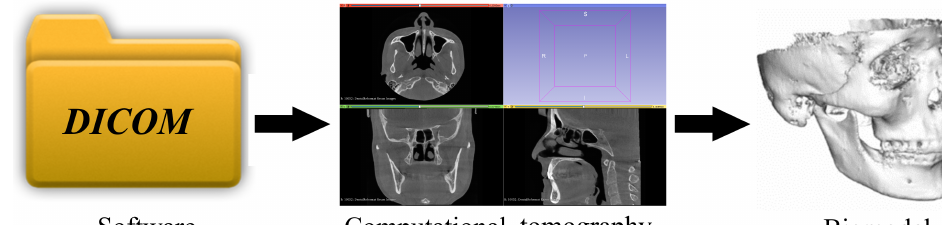
Figure 2. Development of biomodeling of anatomical structures.